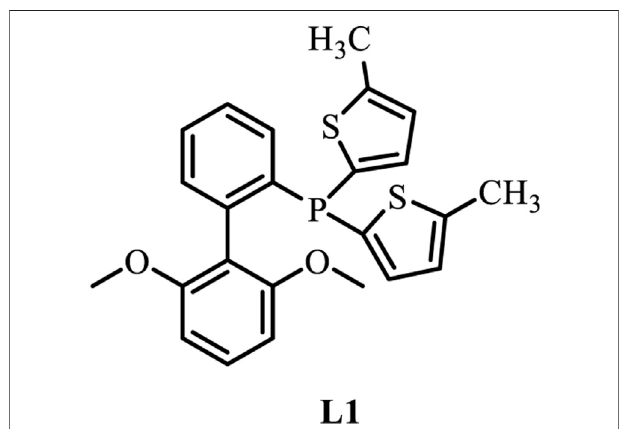
FIGURE 1 | The chemical structure of